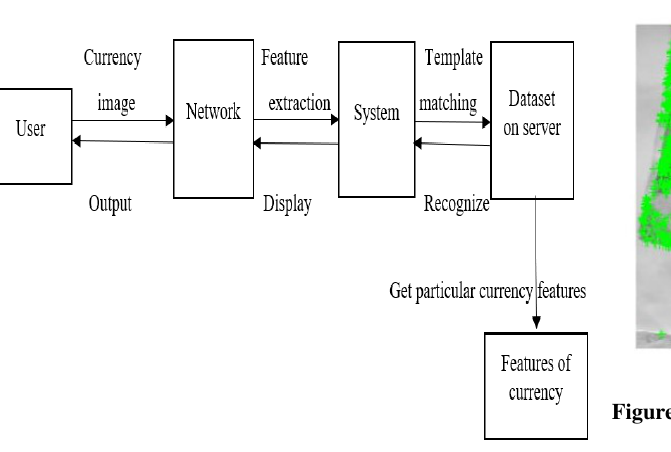
Figure 1. Data Flow Diagram